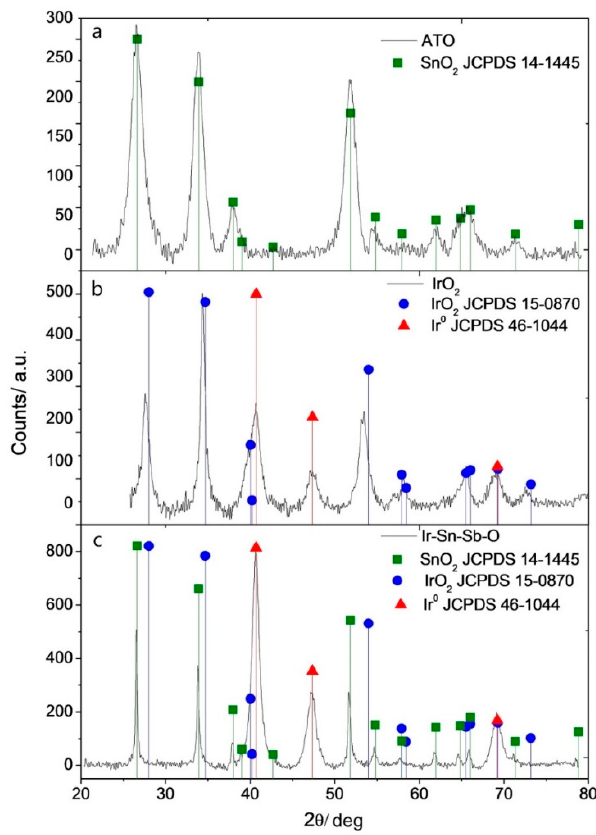
Catalysts 2020 , 10 , x FOR PEER REVIEW ff raction patterns of ( a ) ATO, ( b ) IrO Figure 5. X-ray diffraction patterns of ( a ) ATO, ( b ) IrO 2 and ( c ) Ir-Sn-Sb-O. Figure 5. X-ray di